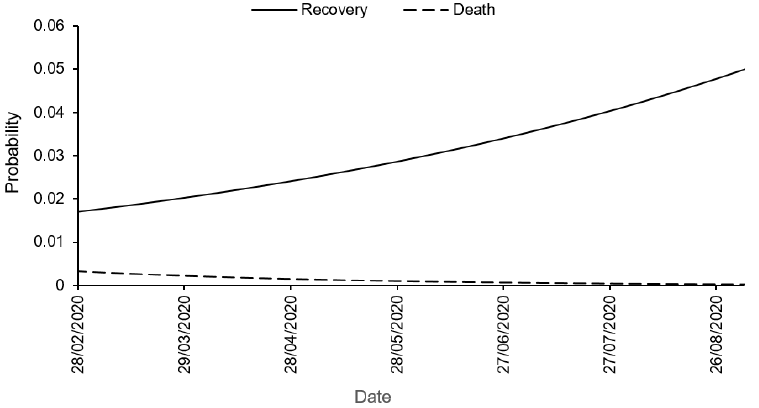
Figure 3. Fitted probabilities of recovery and death in COVID-19 daily case reporting data from West Africa (28 February to 31 August 2020). The fits are based on two logistic regression